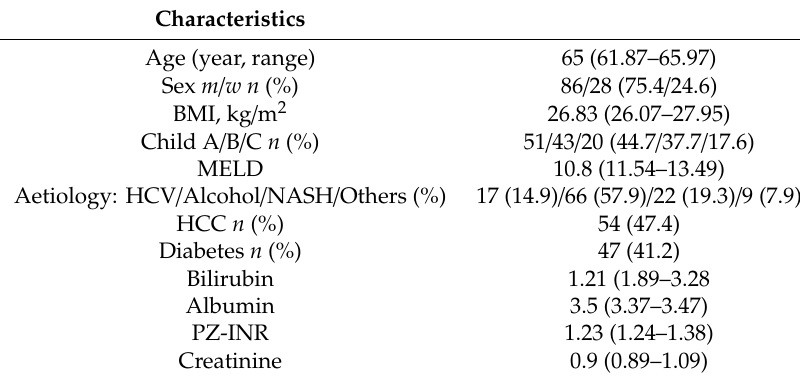
Table 2. Baseline characteristics of 114 liver cirrhosis